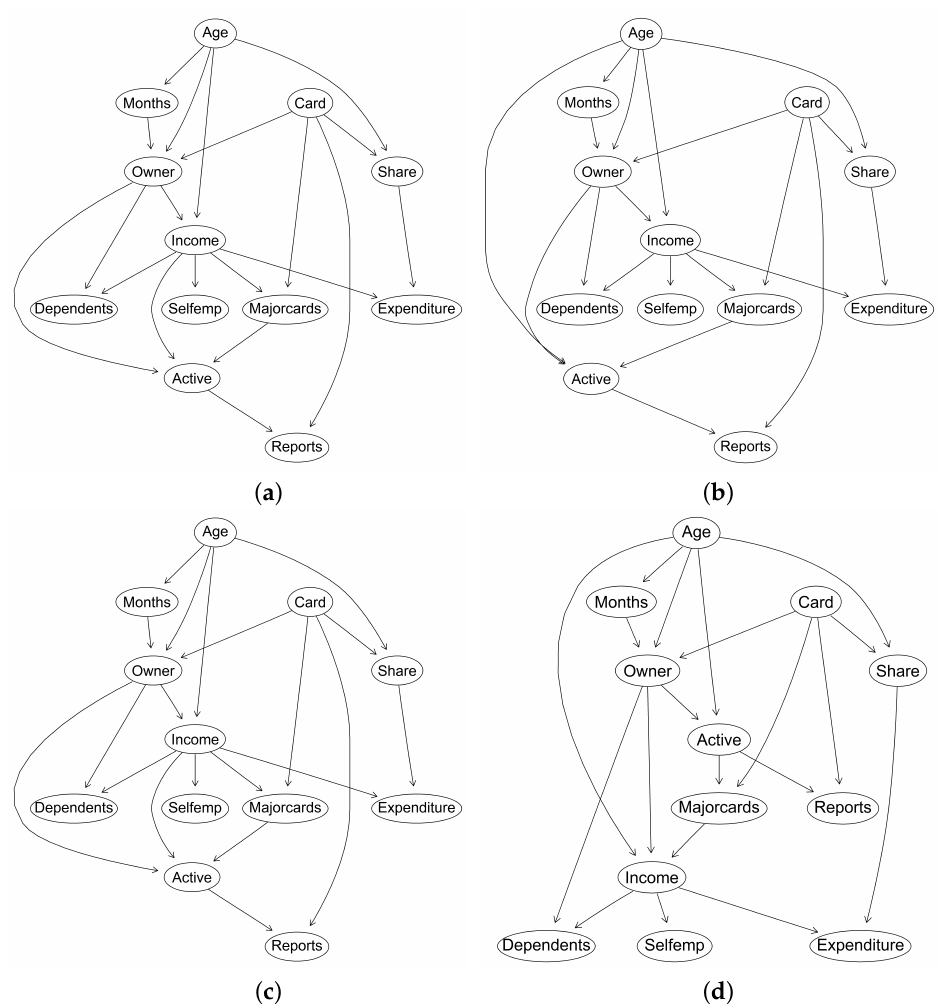
Figure 12. Expenditure data . Estimated BNs using ( a ) FEDHC, ( b ) PCHC, ( c ) MMHC-1 and ( d )